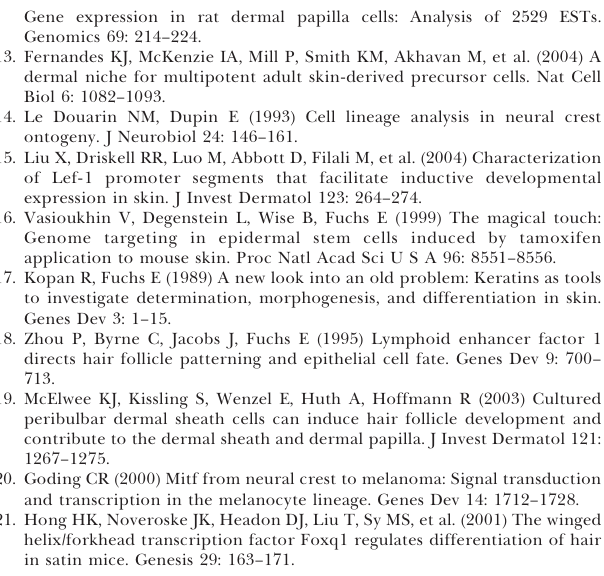
Table S7. Mc Signature Genes As in Table S4. Table S8. Significance Analysis of GO Categories of the Molecular Signatures and the Molecular Backbone Molecular Signature and Backbone genes were grouped functionally into GO categories and statistically analyzed with the ‘‘ Database for Annotation, Visualization and Integrated Discovery ’’ (DAVID 1.0) Web tool. The table contains the p -values of the Fisher exact probability test and the more conservative EASE Score as a statistical measure of enrichment of genes within GO categories. The values for each Molecular Signature and the Molecular Backbone group are arranged in separate tabs. Table S9. GO Classification of Molecular Backbone Complete list of genes with corresponding GO classifications. Note that each gene may be in several categories. GO systems were split into separate tabs. Biological Process, BP; Molecular Function, MF; Cellular Component, CC. Table S10. GO Classification of Mx Signature Complete list of genes with corresponding GO classifications. Note that each gene may be represented in several categories. The list is sorted for classifications, and each gene is hyperlinked to the NCBI LocusLink/EntrezGene entries. Found at DOI: 10.1371/journal.pbio.0030331.st010 (937 KB XLS). Table S11. GO Classification of ORS Signature As in Table S10. Table S12. GO Classification of DP Signature As in Table S10. Table S13. GO Classification of Mc Signature As in Table S10. Table S14. Primers for RT-PCR and Real-Time PCR Primer sequences for RT-PCR and real-time PCR. The same primers were employed for both RT-PCR methods. Found at DOI: 10.1371/journal.pbio.0030331.st014 (24 KB